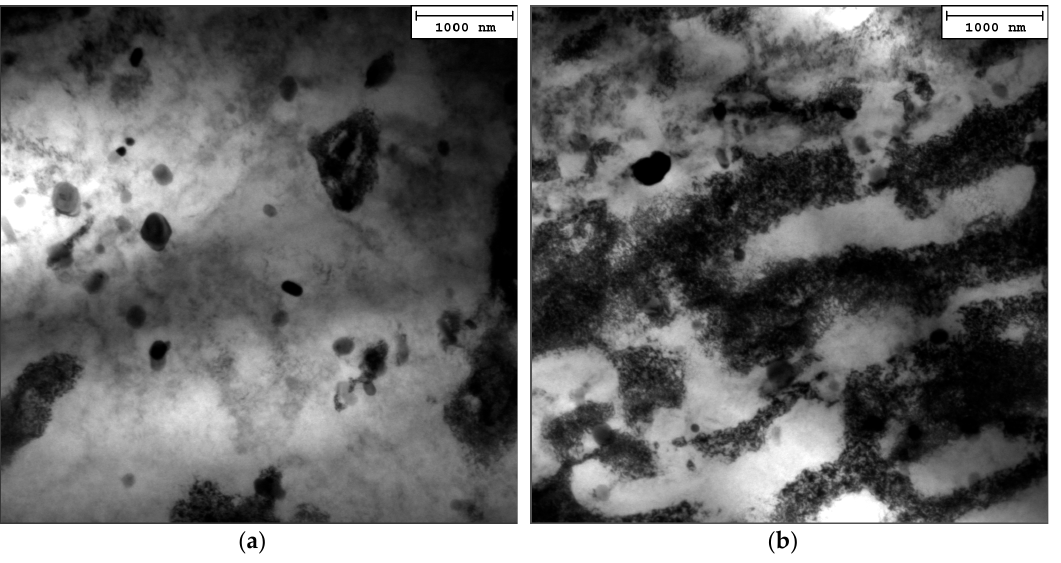
Figure 11. TEM micrographs of SA ( a ) and SAE ( b ) samples.